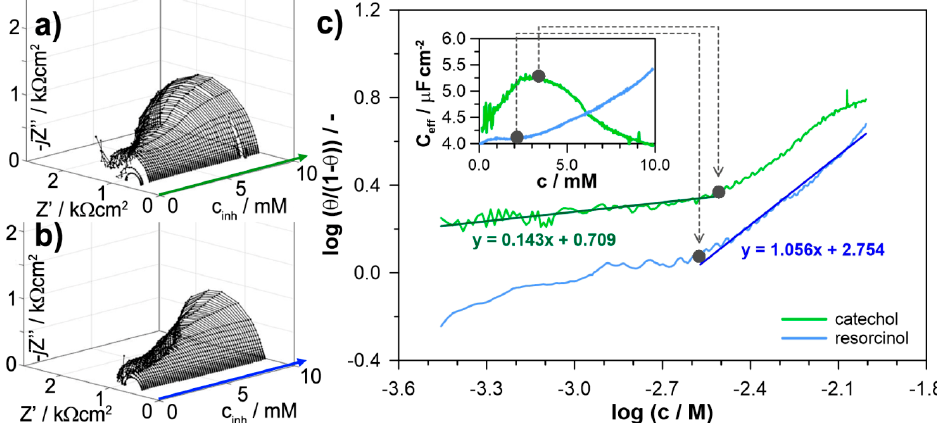
Figure 6. The g-DEIS impedance graphs of aluminum alloy 5754 in bicarbonate buffer (pH = 11), presented in Nyquist projection versus ( a ) catechol and ( b ) resorcinol concentration changes during its injection to corrosion cell. ( c ) Langmuir model of adsorption isotherms drawn based on instantaneous R ct changes, in the inset the instantaneous changes of effective capacitance C eff .